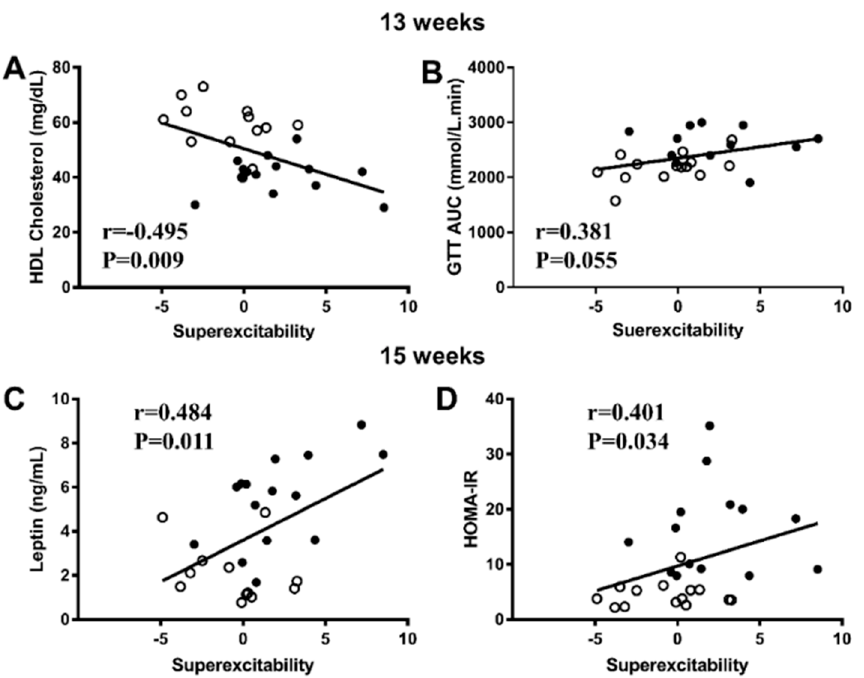
mass (0.506, p = 0.004), fasting plasma leptin ( r = 0.484, p = 0.011, Figure 5C), HOMA-IR (Spearman r = 0.401, p = 0.034, Figure 5D) and fasting plasma insulin (Spearman r = 0.379, p = 0.047), but not inflammatory markers TNF- α ( r = 0.373, p = 0.088) or IL-6 ( r = 0.200, p = 0.349). Finally, there were significant negative correlations between IENFD and fasting plasma triglycerides ( r = − 0.527, p = 0.036, n = 16) and the TyG index ( r = − 0.527, p = 0.043, n = 16).